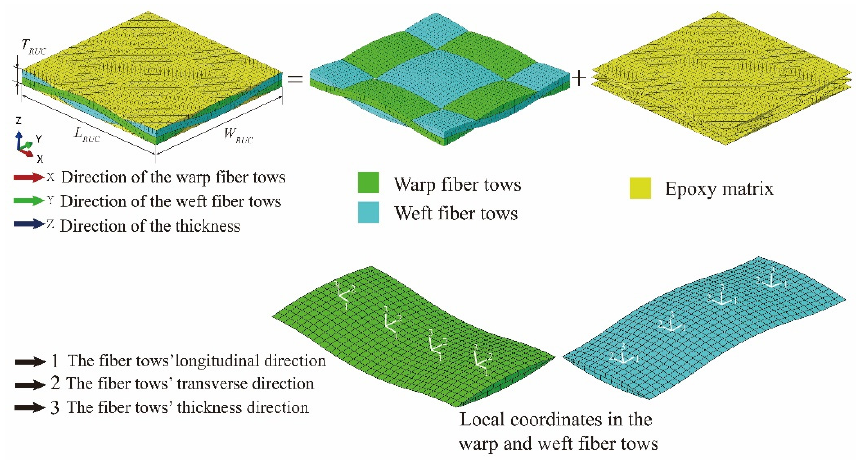
Figure 16. Meso-scale FE model of the utilized T300/Epoxy PWF composite.